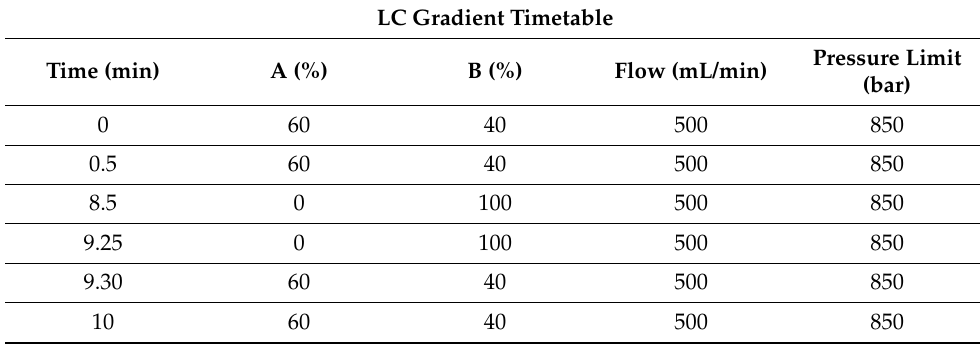
Table 4. LC gradient conditions used in sphingolipid analysis by mass spectrometry.